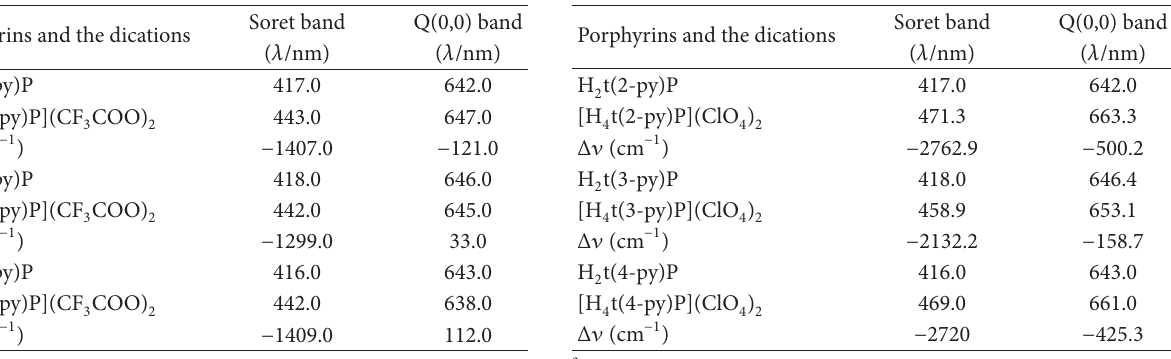
T 3: UV-vis spectral data for the diprotonated H